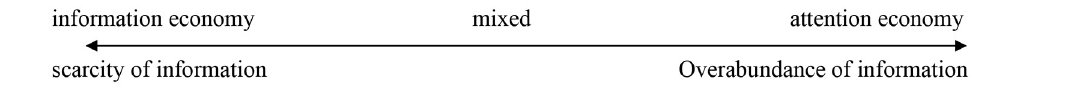
FIGURE 3 | Information economy/attention economy